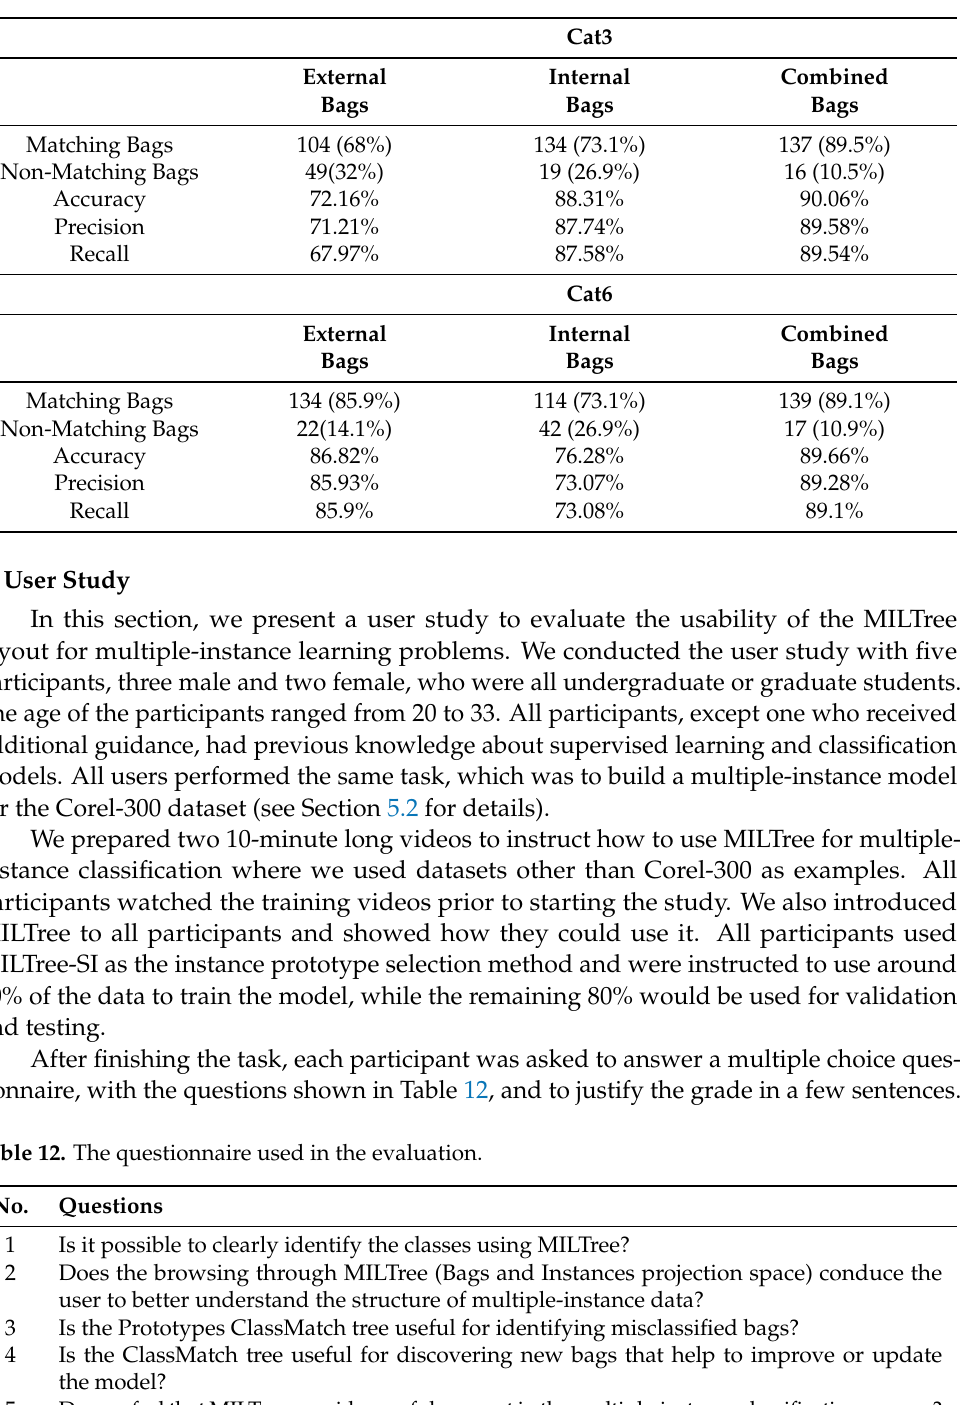
Table 11. Results of multi-instance classification using three types of training